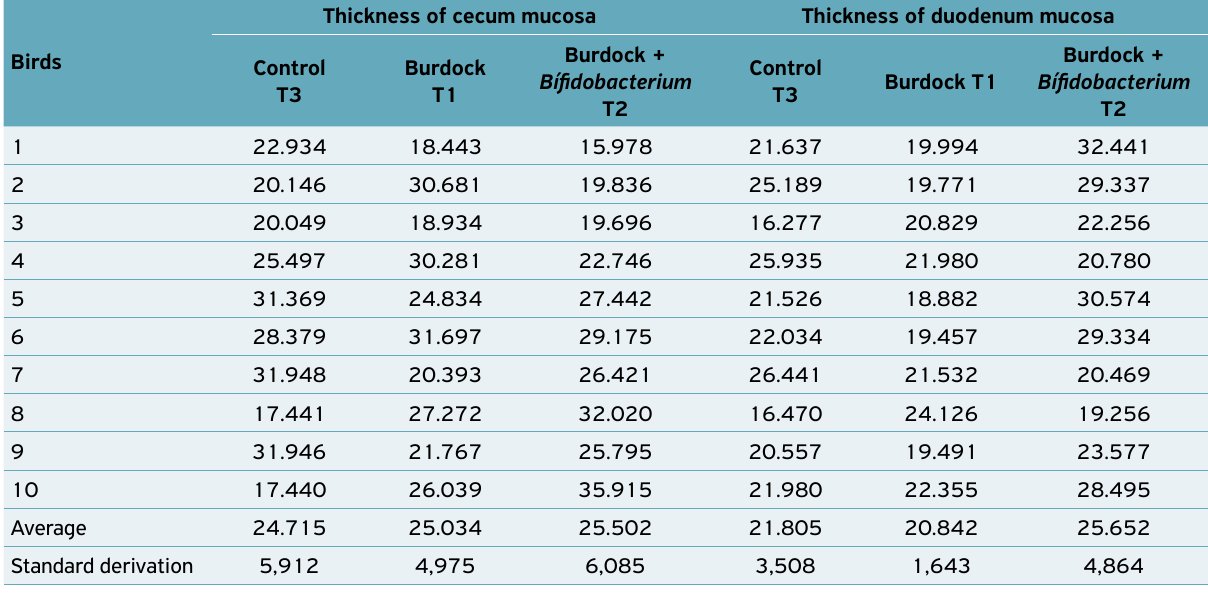
Table 3. Intestinal morphometry of broilers treated with inulin broth (T1), with inulin and Bifidobacterium (T2) and negative control (T3): Test